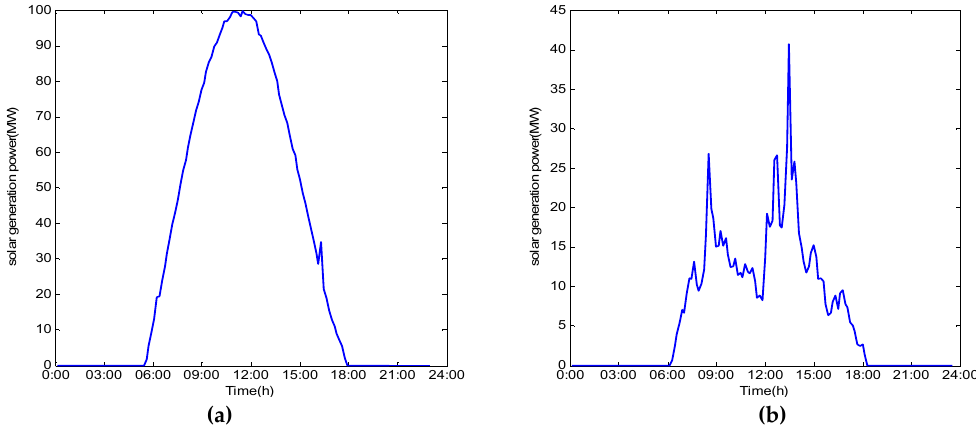
Figure 3. Input solar generation power. ( a ) Sunny day; ( b ) cloudy/snowy day.